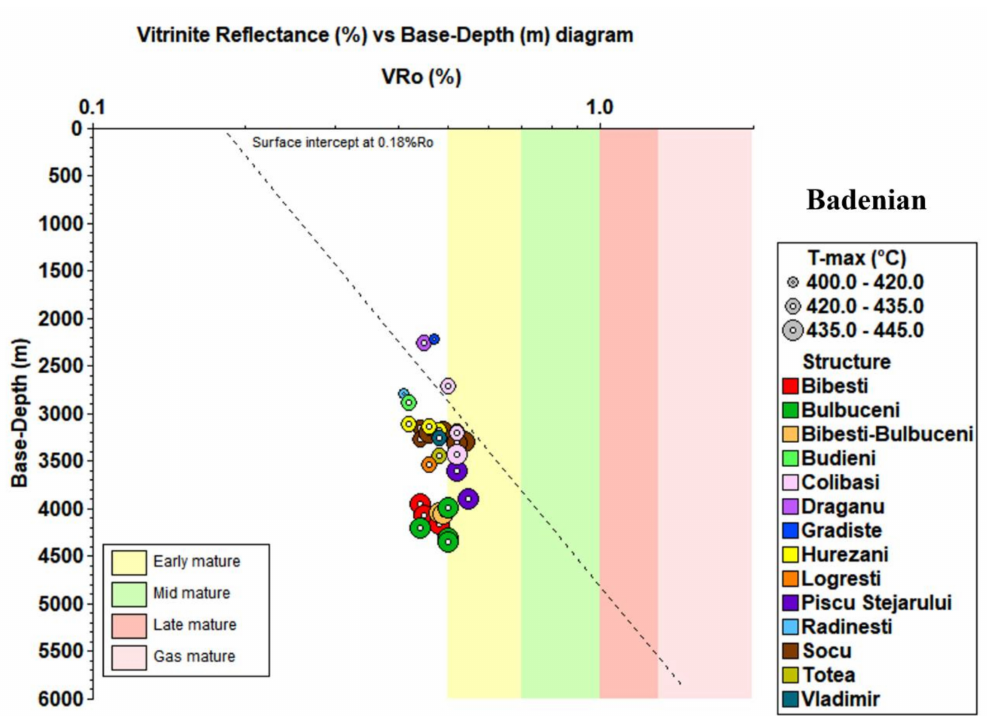
Figure 10. Vitrinite reflectance VR o (%) vs. depth (m), showing the thermal maturity of the Upper Badenian source rocks from the central-southern part of the Getic Depression.